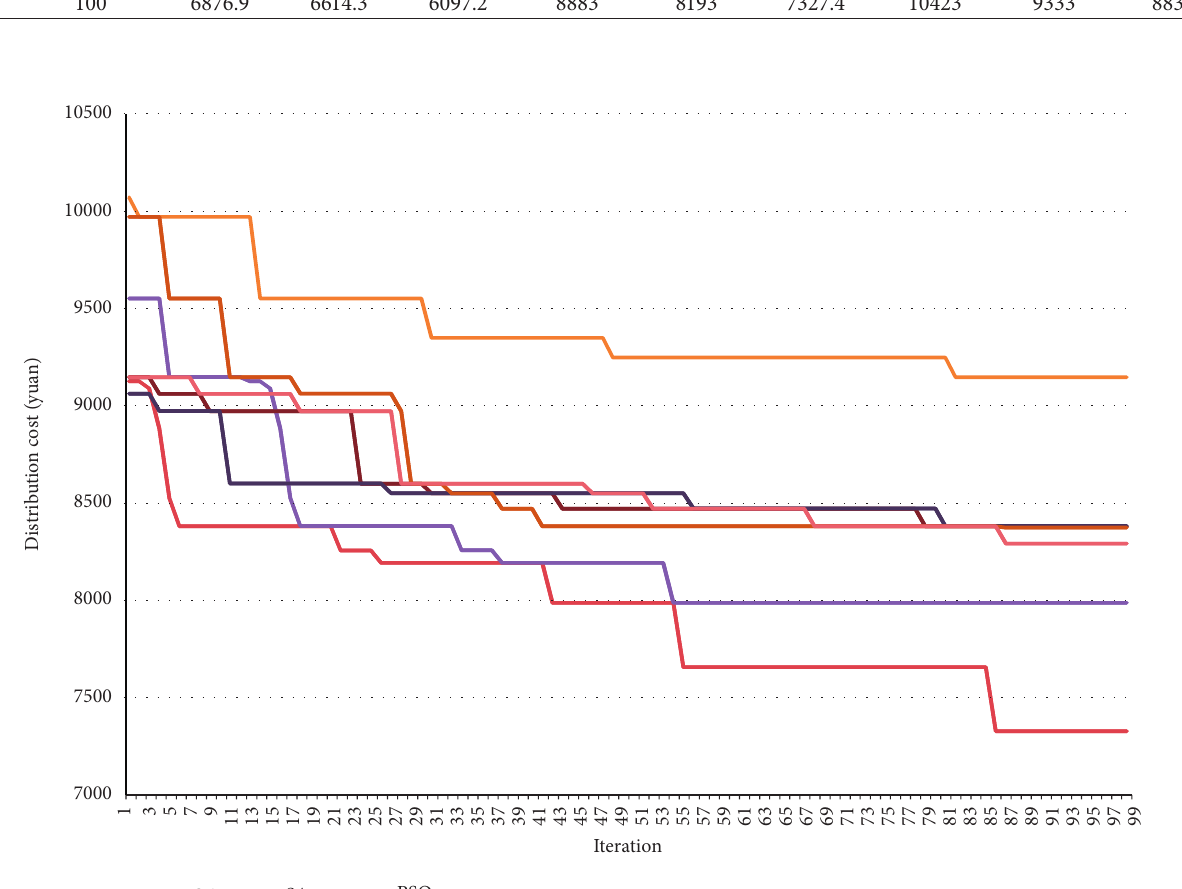
Figure 10: Effects of iteration ( t ) of each algorithm on distribution cost in the medium speed.